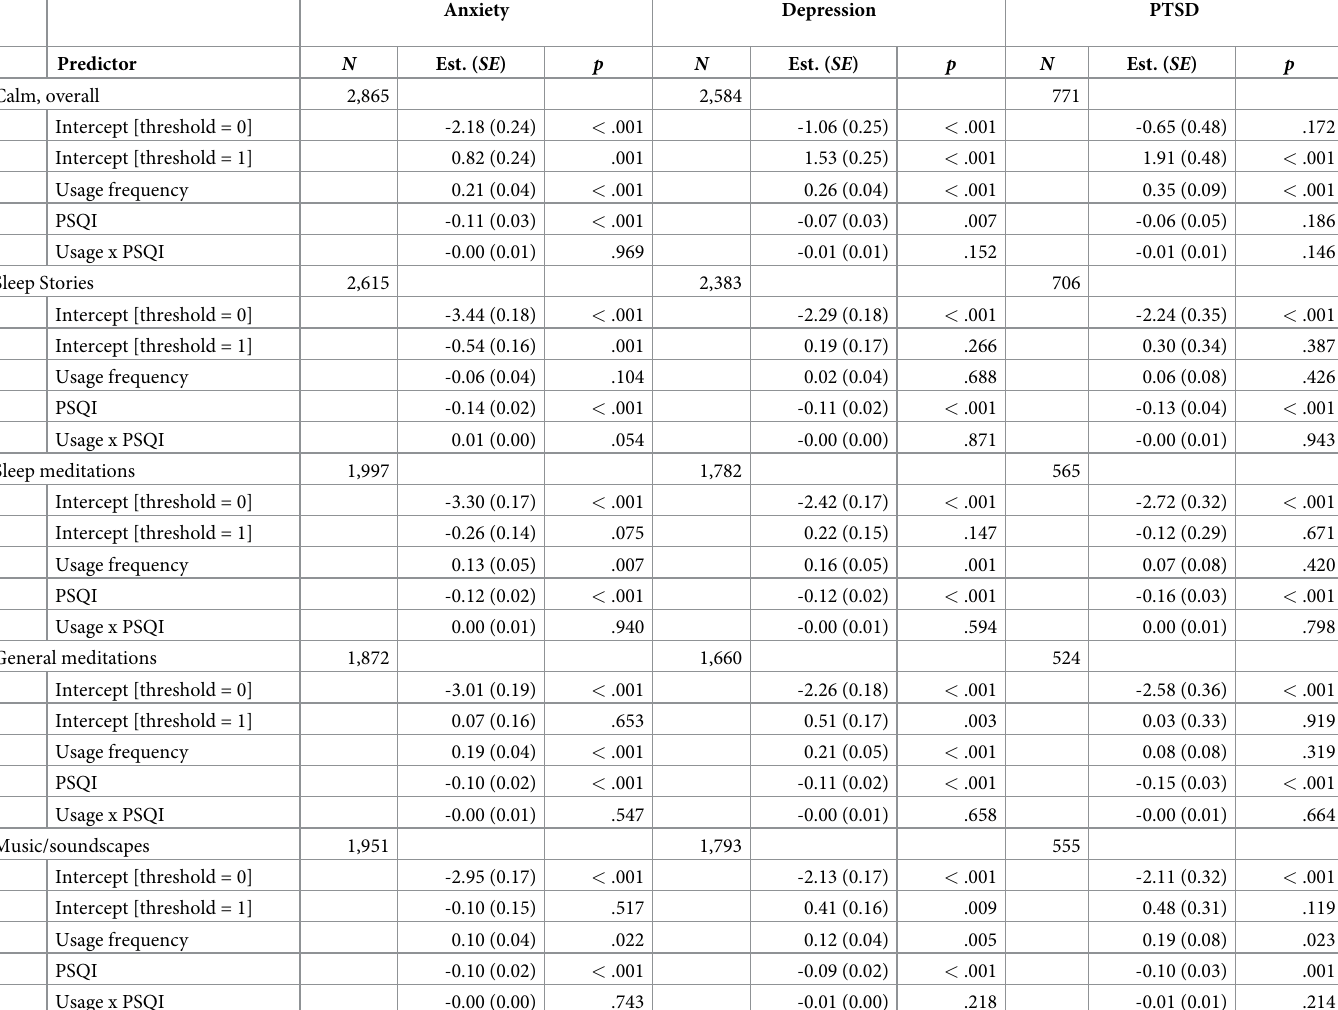
Table 10. Parameter estimates for regressions models of improvements in mental health diagnoses based on frequency of using Calm and its components, PSQI scores, and the interaction between frequency of use and PSQI (i.e., Step 2). Anxiety Depression PTSD